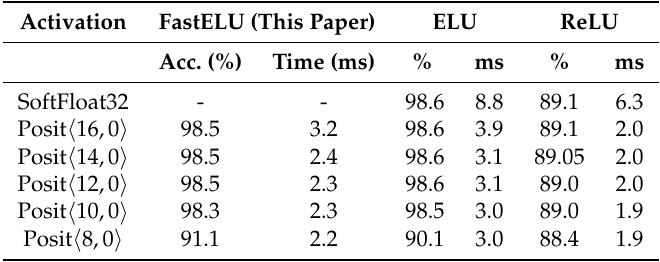
Table 8. Comparison using Posits for the MNIST dataset for three different activation functions: fast approximated version of ELU (FastELU), exact ELU, and ReLU. Accuracy of the neural network and mean sample inference time are